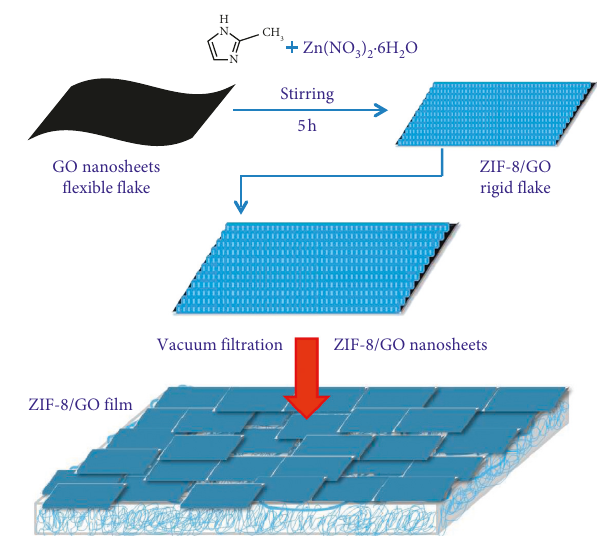
Figure 6: The detailed preparation process of the composite film.